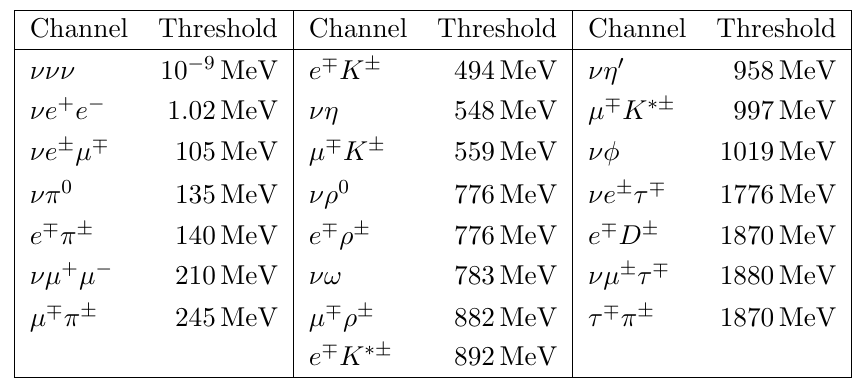
Table 1 . All the available channels for a HNL with a mass below the D (cid:6) sorted by threshold mass. The active neutrino is considered massless, when compared to the masses of the other